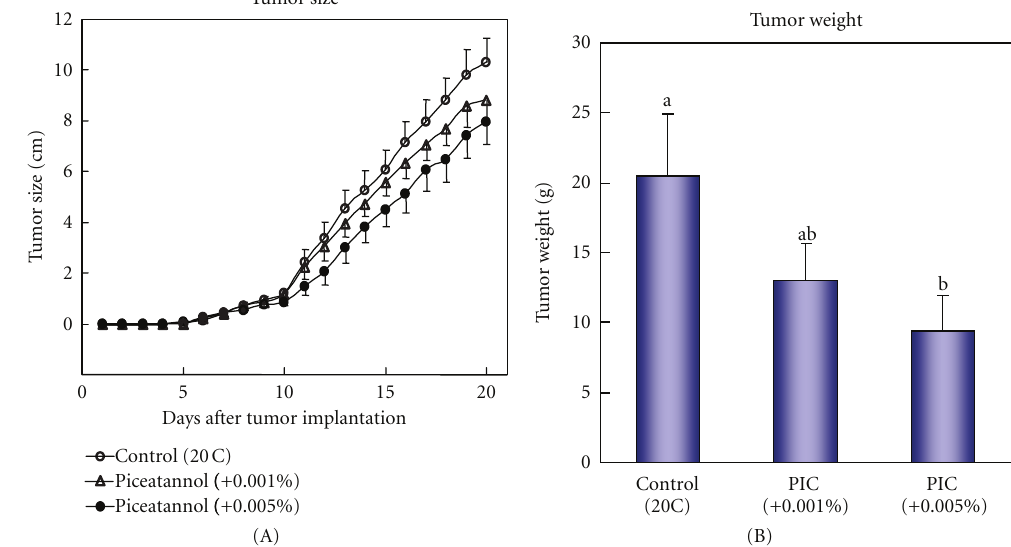
Figure 3: E ff ect of piceatannol on tumor size (A) and weight (B) of solid tumors in hepatoma-bearing rats. (A) Tumor size was determined in live animals by measuring the three-dimension sizes (height, length, and width). Each value represents the mean ± SEM of nine (control and +0.005% groups) and ten (+0.001% group)